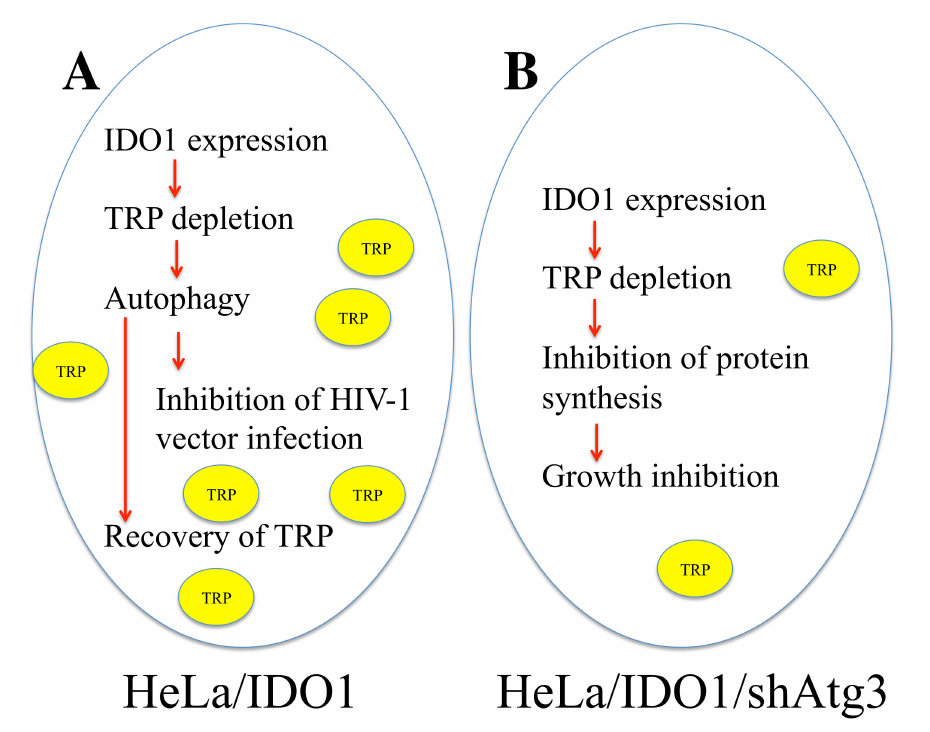
Figure 7. Mechanism of IDO1-mediated inhibition of HIV-1 infection. ( A ) In IDO1-expressing HeLa cells, tryptophan is digested, and cellular tryptophan level is decreased. As a result, autophagy is enhanced. HIV-1 vector infection is inhibited by activated autophagy. Entered HIV-1 particles may be degraded in autophagosomes. On the other hand, proteins and organelle are digested by autophagy, and tryptophan level is recovered. Thus, protein synthesis and cell growth are not suppressed. ( B ) In HeLa/IDO1/shAtg3 cells, IDO1 digests tryptophan, and cellular tryptophan level is